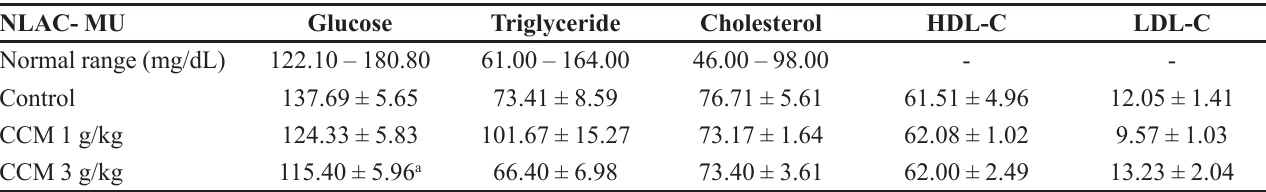
TABLE II - Effects of CCM (1, 3 g/kg) or distilled water (control) consumption for 6 weeks on the fasting levels of serum glucose and lipids of middle-aged male rats NLAC- MU